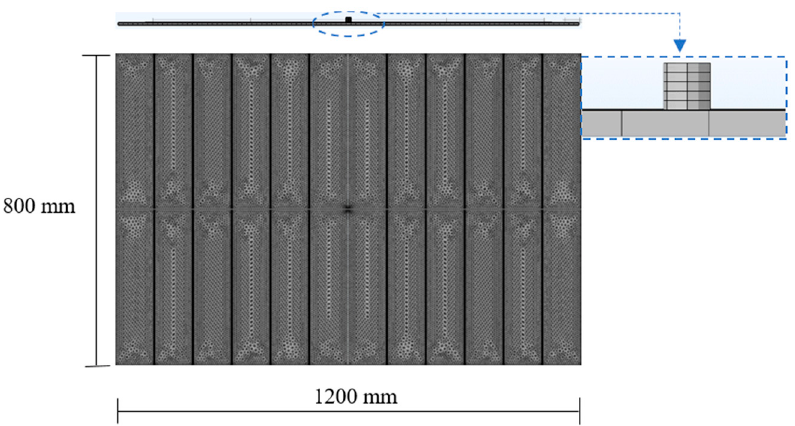
Figure 18. Numerical model of the grouting diffusion test.